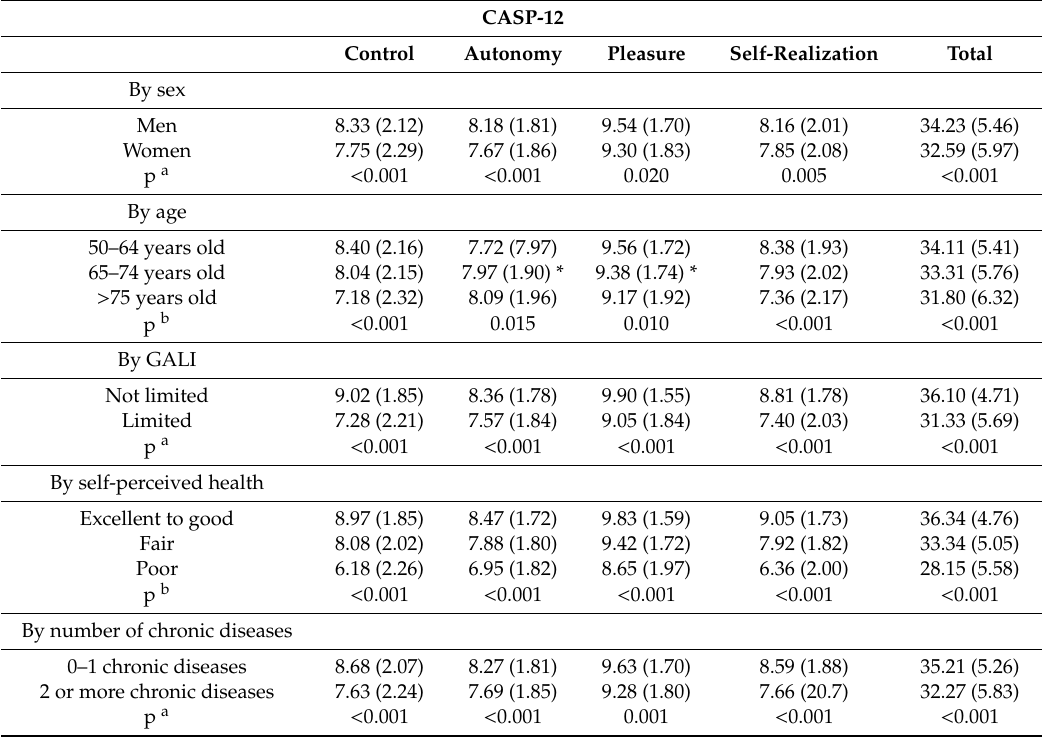
Table 4. Discriminative validity of CASP-12.